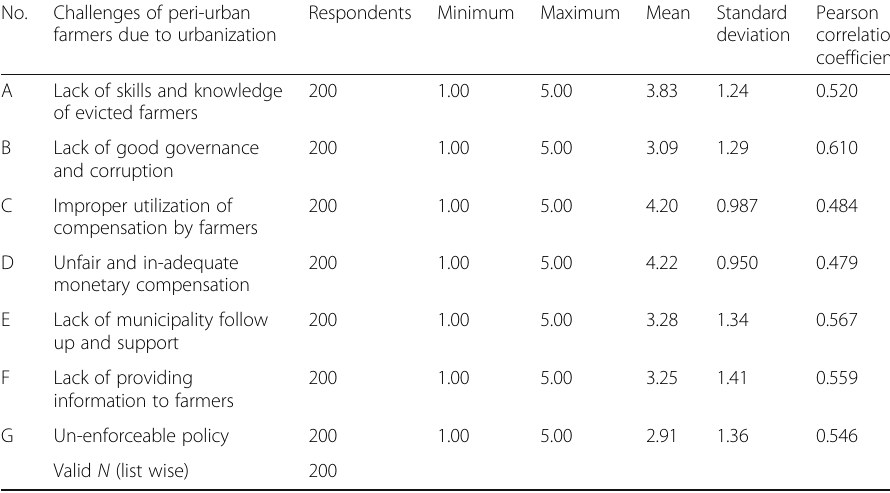
Table 9 Challenges that hinders peri-urban farmers due to urbanization